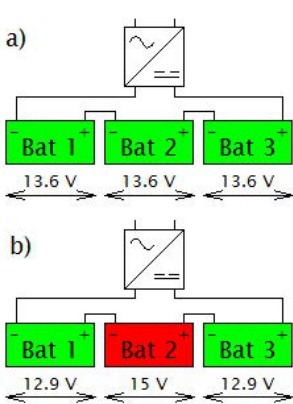
Figure 3. Voltage distribution in battery set during constant voltage charging. ( a ) represents the battery set without any damaged battery-voltage levels are equally distributed, while in ( b ) the battery set contains one damaged battery where the voltage level is increased.